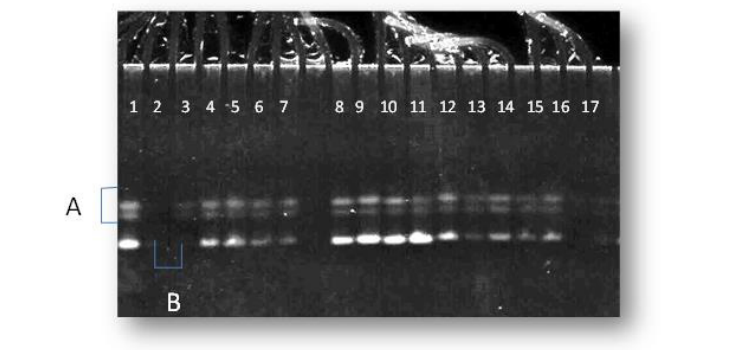
Fig. 3. The electrophoresis pattern of PCR-SSCP technique for MIR-196a2 gene, ( Pattern A:3 bands) and (Pattern B:one band)for both patients and